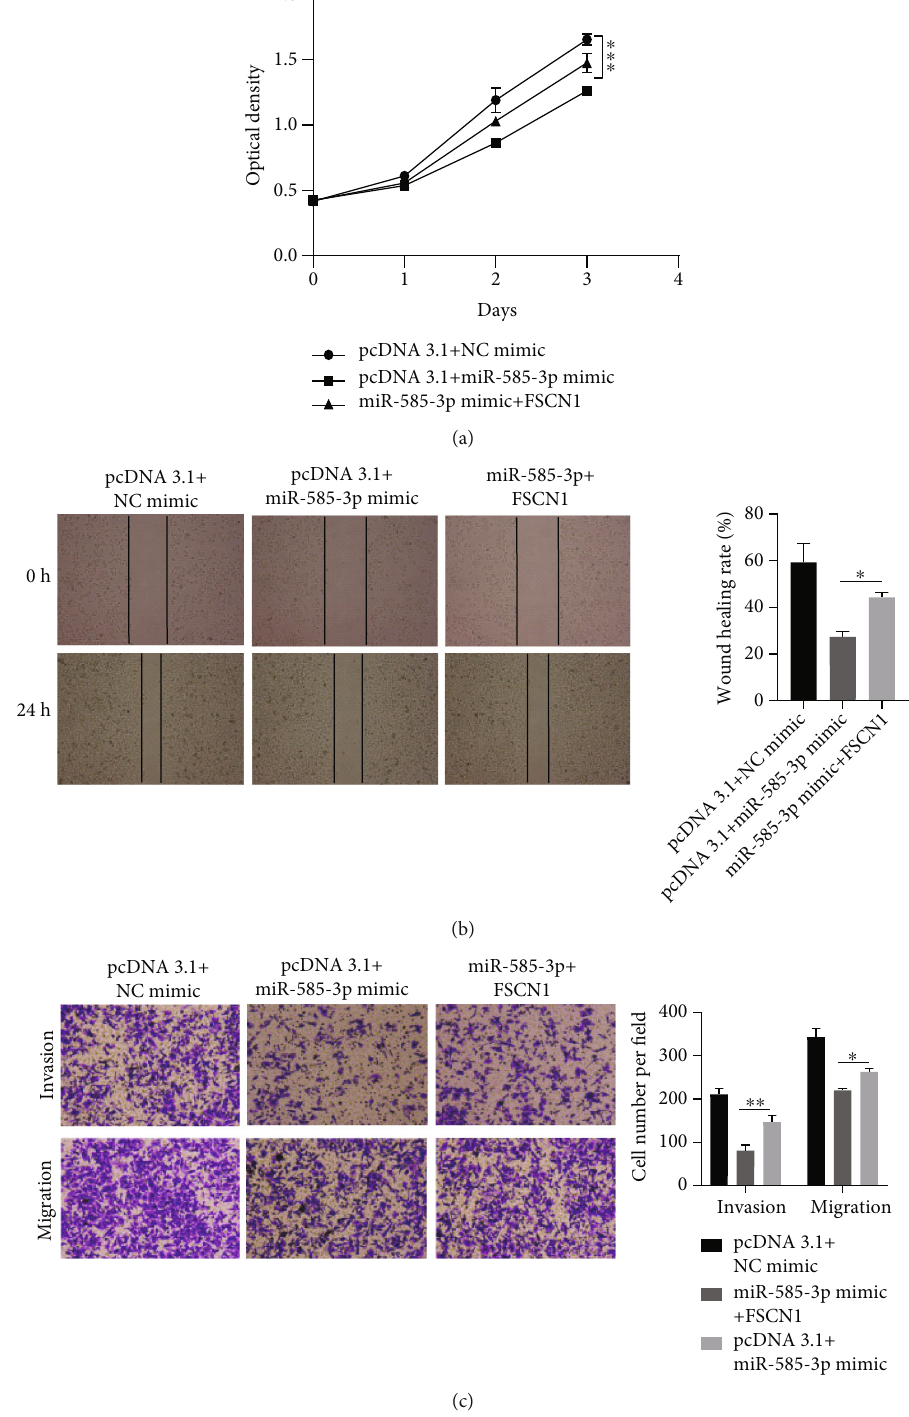
Figure 4: Overexpression of miR-585-3p inhibits proliferation, migration, and invasion of OC cells by targeting FSCN1. (a) RT-qPCR was used to detect the growth of OC cells after cotransfection of miR-585-3p mimic and FSCN1. (b) Scratch wound healing assays was used to detect the lateral migration ability of OC cells after cotransfection of miR-585-3p mimic and FSCN1. (c) Transwell assay was used to detect the invasive ability of OC cells after cotransfection of miR-585-3p mimic and FSCN1. ∗ P < 0 : 05 , ∗∗ P < 0 : 01 , and ∗∗∗ P < 0 : 001